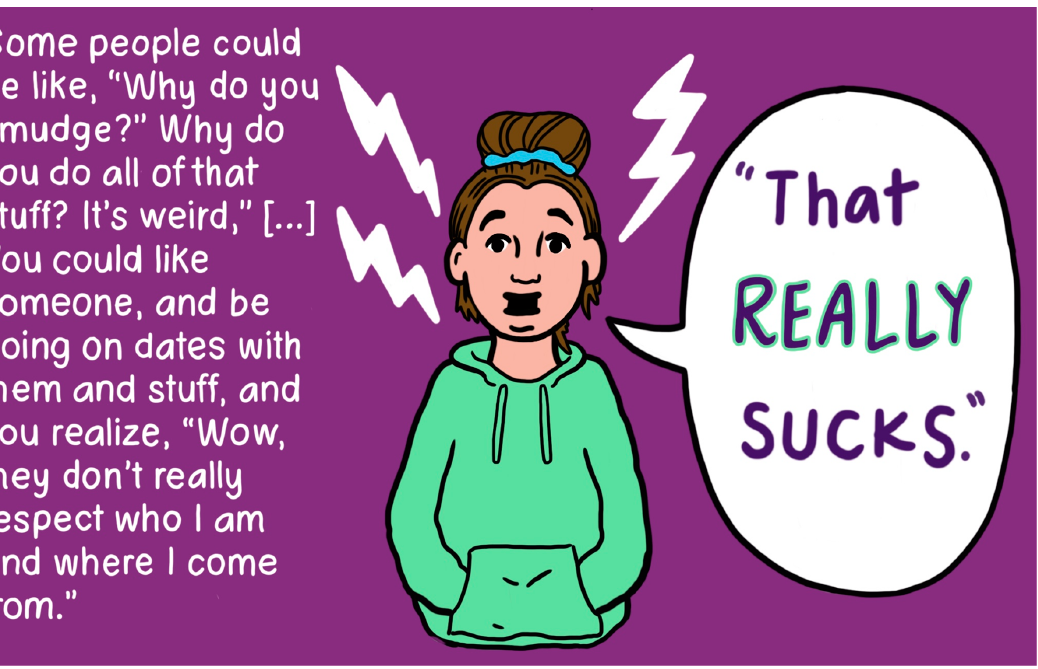
Figure 7. A young woman wearing a hoody has both hands tucked into the pockets and is “struck” with a realization and symbolized by three lightning bolts. See I.D. 7 in Appendix A.